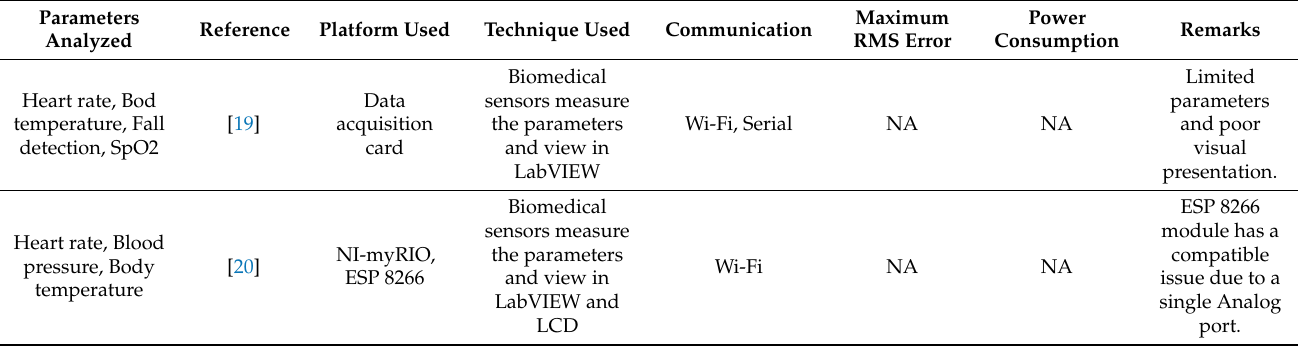
Table 4. Comparison of available techniques for IoT and LabVIEW-based health care